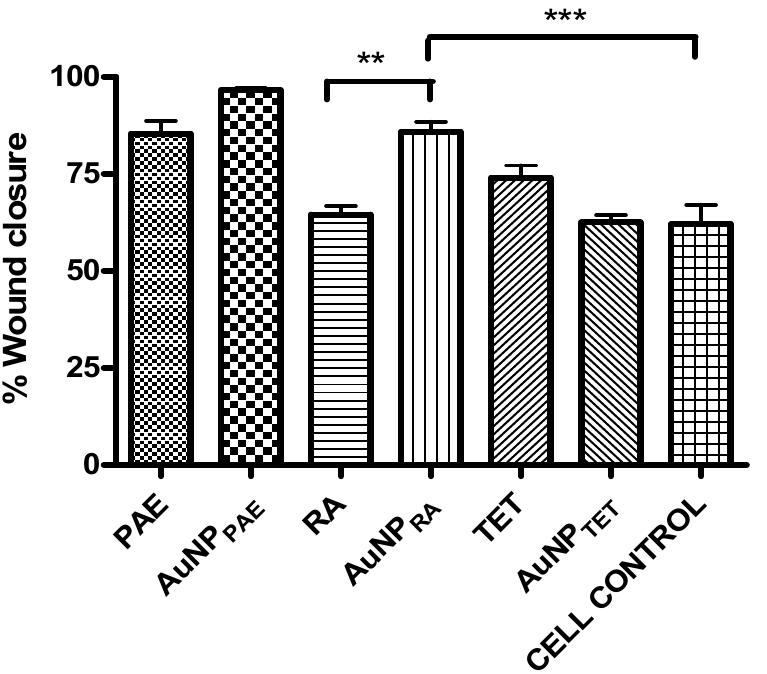
Figure 5. Percentage wound closure comparison between gold nanoparticle samples and their respective controls. AuNP PAE : gold nanoparticles formed from Plectranthus aliciae ethanolic extract (PAE); AuNP RA : gold nanoparticles formed from rosmarinic acid (RA); AuNP TET : gold nanoparticles formed from tetracycline (TET). One-way ANOVA followed by Tukey ′ s multiple comparison test, n = 3. ** p < 0.01, *** p < 0.001 .